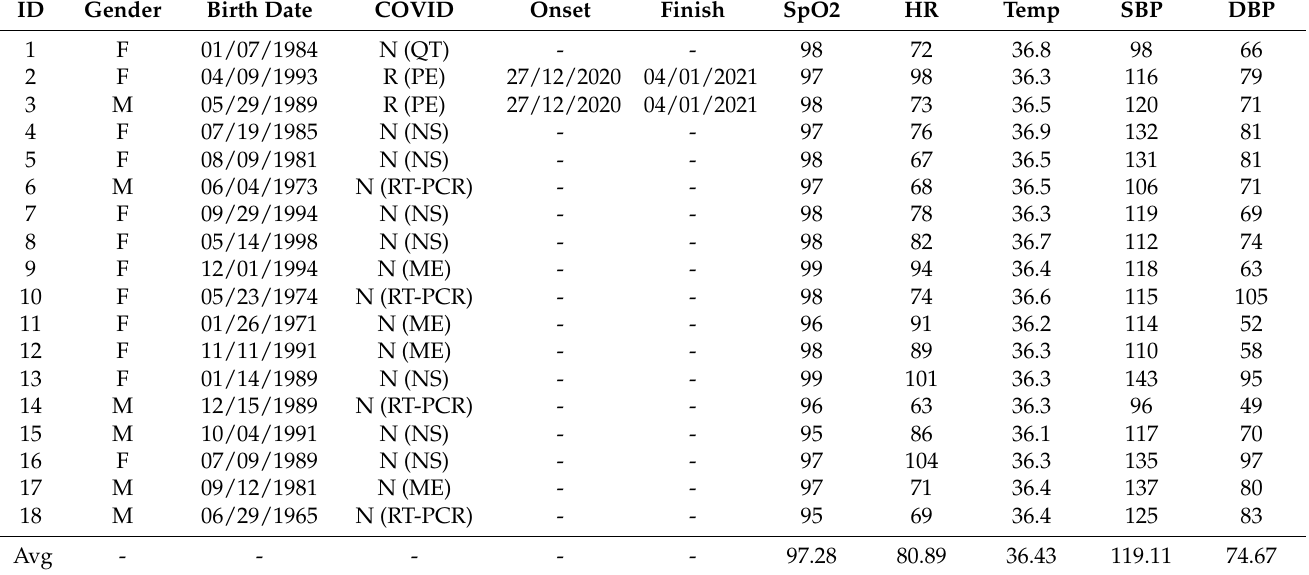
Table A2. Measurements and volunteers’ information taken during the IPMA’s evaluation by Brazil- ian volunteers.